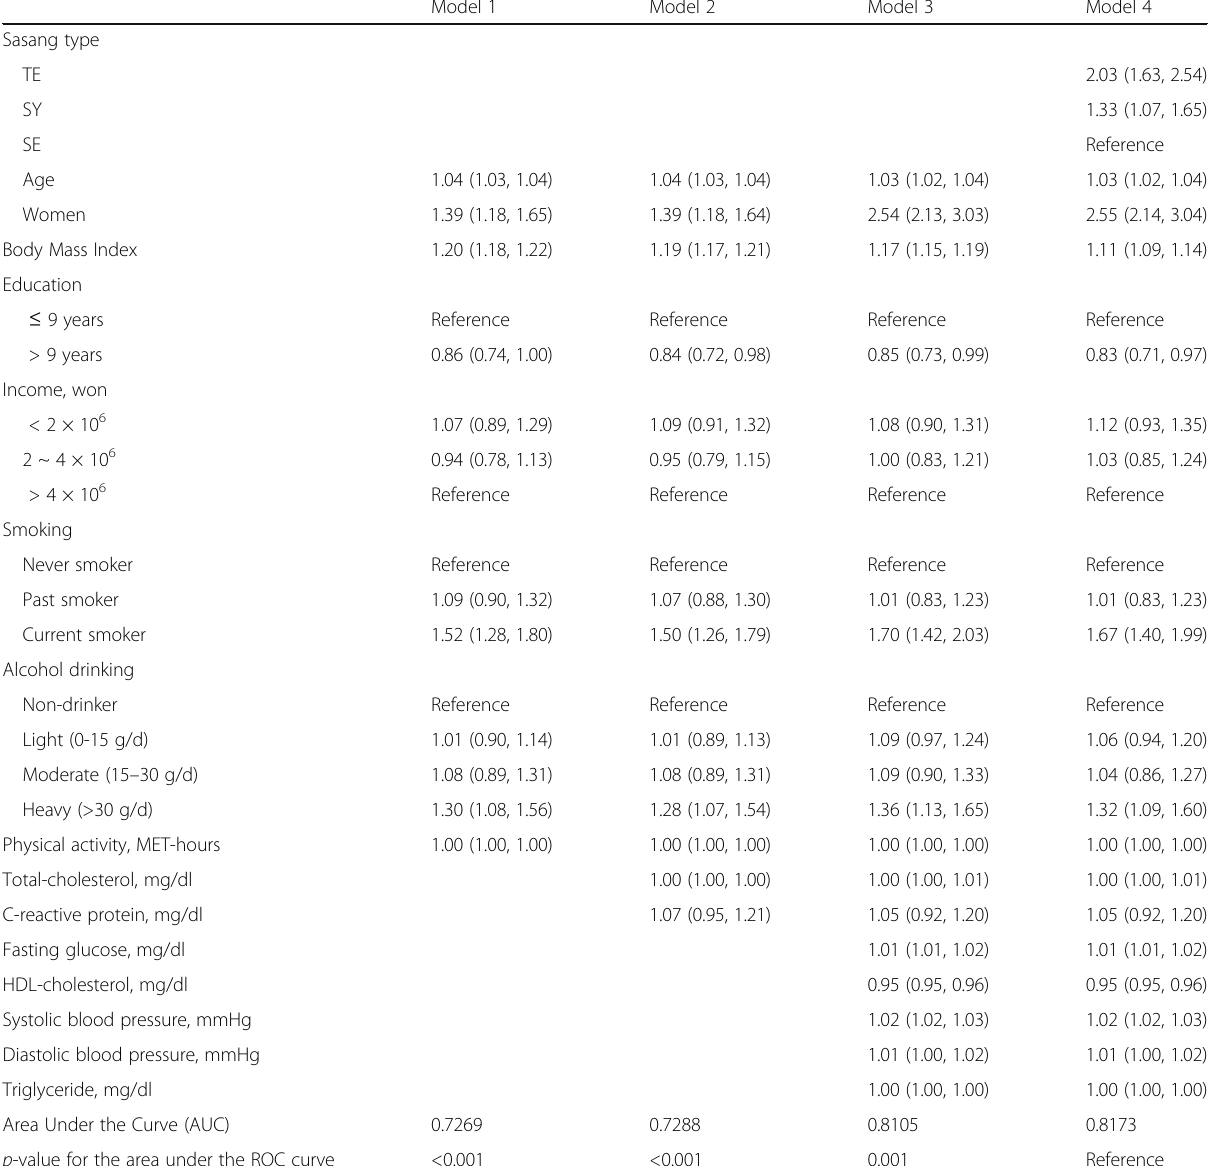
Table 2 Risk Prediction Models of the Sasang Constitution ( n =